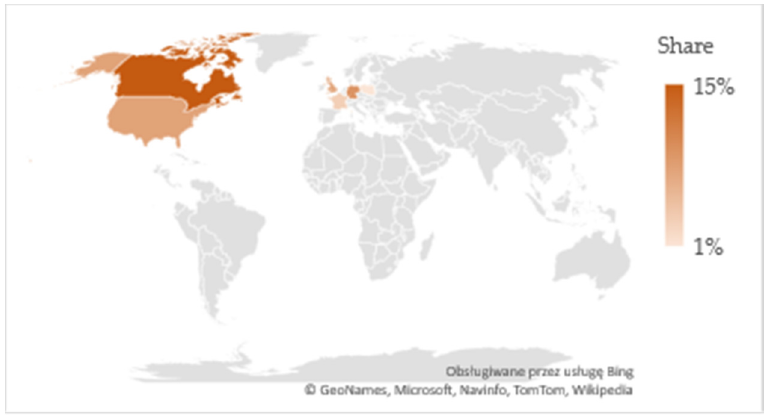
Figure 10. The map of spatial distribution of demand intensity of studied concept skills for energy executives by countries.